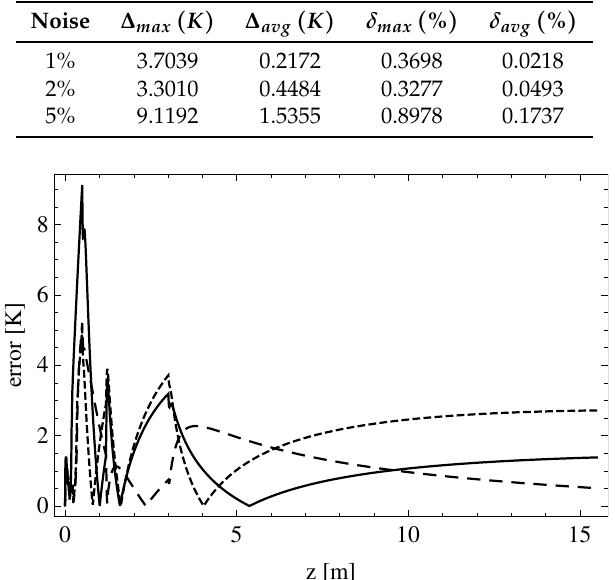
Figure 7. Absolute error of temperature reconstruction in the control points for measurements read at every 0.02m and burdened by 5% error (one step optimization).